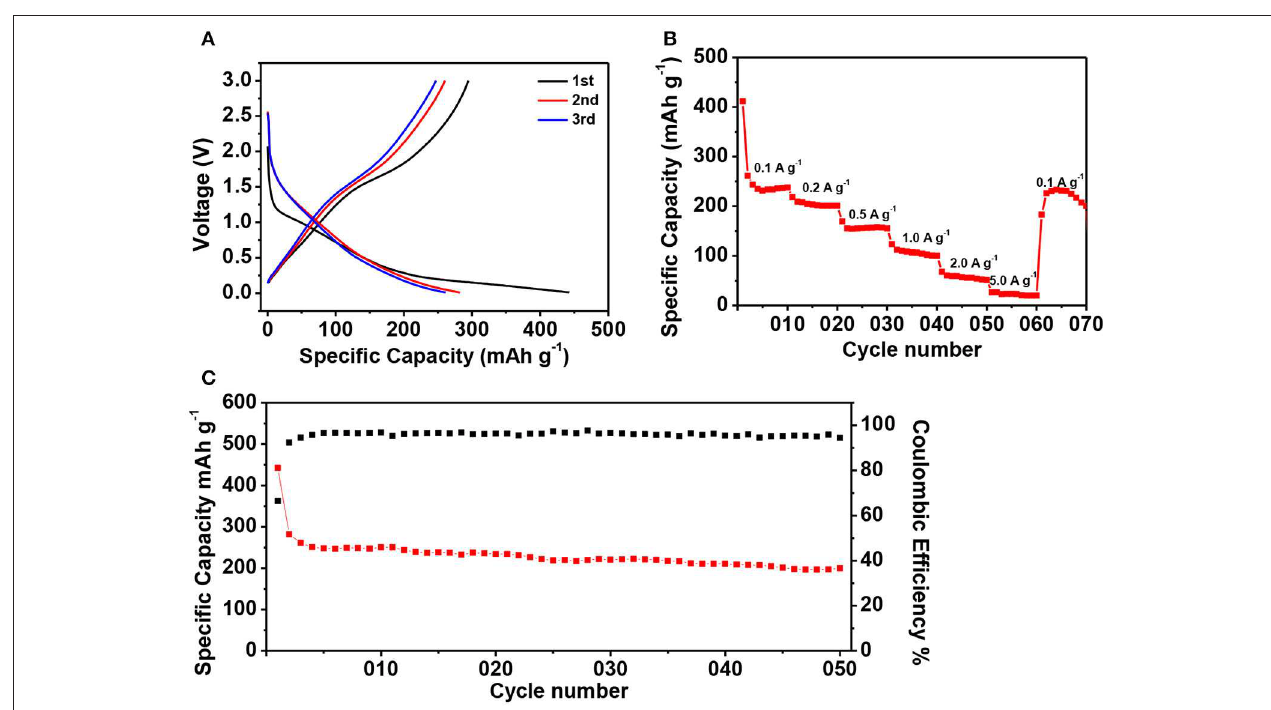
FIGURE 8 | The electrochemical performance of ZIF-67-C@MoS 2 in PIBs. (A) Charge/discharge curves of ZIF-67-C@MoS 2 at 0.1A g − 1 in the 1st, 2nd, and 3rd cycles. (B) Rate capability at different rates between 0.01 and 3V. (C) Cycling performance of ZIF-67-C@MoS 2 electrode at a current density of 0.1A g − 1 .